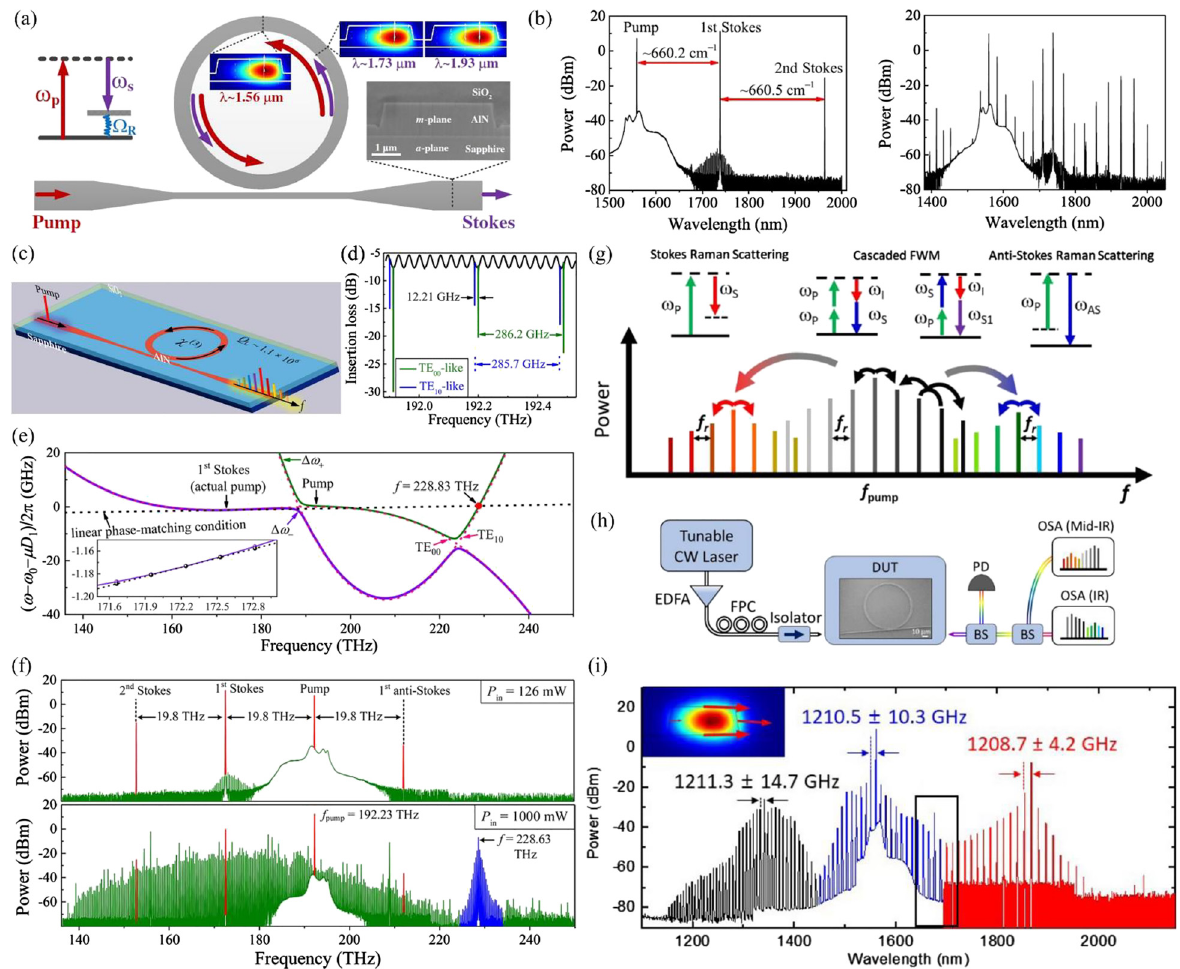
Figure 14: AlN-based integrated devices for Raman-assisted frequency comb generation. (a)SchematicofAlNmicroringforRamanlasing,includingenergylevelforSRSontheleft,calculatedmodeintensityprofilesatpump,firstand second Raman Stoke, as well as the cross sectional SEM image of fabricated waveguide on the right. (b) Left panel: Raman lasing spectrum underon-chipTE-polarizedpumppowerof ∼ 126mW.Rightpanel:frequencycombgeneratedaroundpump, fi rstandsecondStokesunderon- chip TE-polarizedpowerof ∼ 158mW.(a) – (b) Adapted with permissionfrom [101]© The Optical Society.(c) Schematicof single-crystalline AlN microring on sapphire substrate for Raman-assisted Kerr comb generation. (d) Transmission spectra for TE 00 - and TE 10 - like modes, with ring radius of 80 μ m. (e) Calculated relative frequency between the hybrid mode and the unperturbed TE 00 mode. Magenta dashed lines represent the unperturbed TE 00 and TE 10 modes. Black dashed line represents the linear phase-matching condition with fi rst Stokes line as pump for FWM process. Inset shows the zoom-in view of the tangent property at fi rst Stokes frequency. (f) Raman-assisted comb pumped at TE 00 -like mode with low pump power P in = 126 mW (top panel) and high pump power P in = 1000 mW (bottom panel). Pump, Stokes and anti-Stokes are indicatedbyredlines.Raman-assistedcombisindicatedbygreenlines.Comblinesgeneratedbyavoidedmodecrossingareindicatedinblue lines. (c) – (f) Adaptedwith permissionfrom [70].Copyright (2018)AmericanChemicalSociety.(g)Principleof broadbandRaman-assistedKerr comb generation. (h) Fabricated device characterization setup. DUT: device under test. BS: beam splitter. (i) Measured spectrum of Raman- assistedbroadbandfrequencycomb,whenDUTisunderTEmodeexcitationaround1550nm.Bluecomblinesaregeneratedthroughcascaded FWM.Blackandredcomblinesarecontributedbytheanti-StokesandStokesRamanscattering.Frequencygapbetweentwolinesiscloseto1 FSR of the microring,which indicates thatthe Raman-assisted comb linesare originatedfrom FWM. Inset: simulated TE mode intensity pro fi le at 1550 nm within the designed microring waveguide. (g) – (i) Adapted with permission from [100] © The Optical